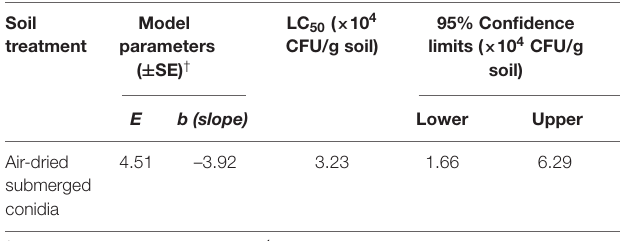
TABLE 3 | Modeling concentration–parasitism relationship and estimation of median lethal concentration (LC 50 ) of C. rosea (strain CMAA1284) submerged conidia against sclerotia of S. sclerotiorum (strain CMAA1105) under the controlled environmental conditions (14 days incubation, 25 ± 1 ◦ C with 12:12 h